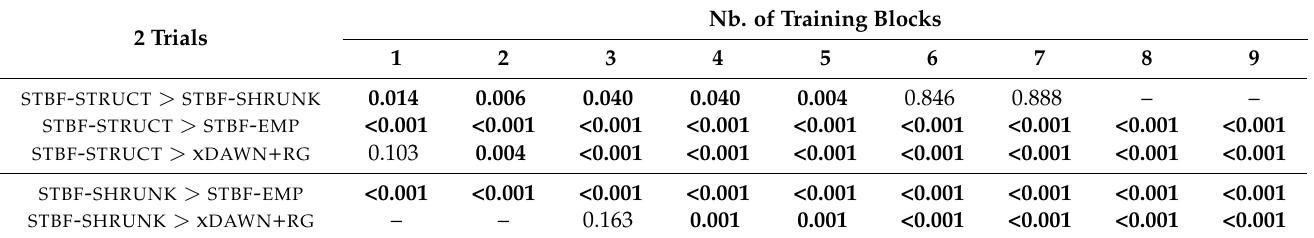
Table 2. p -values as in Table 1, averaging over two testing trials.